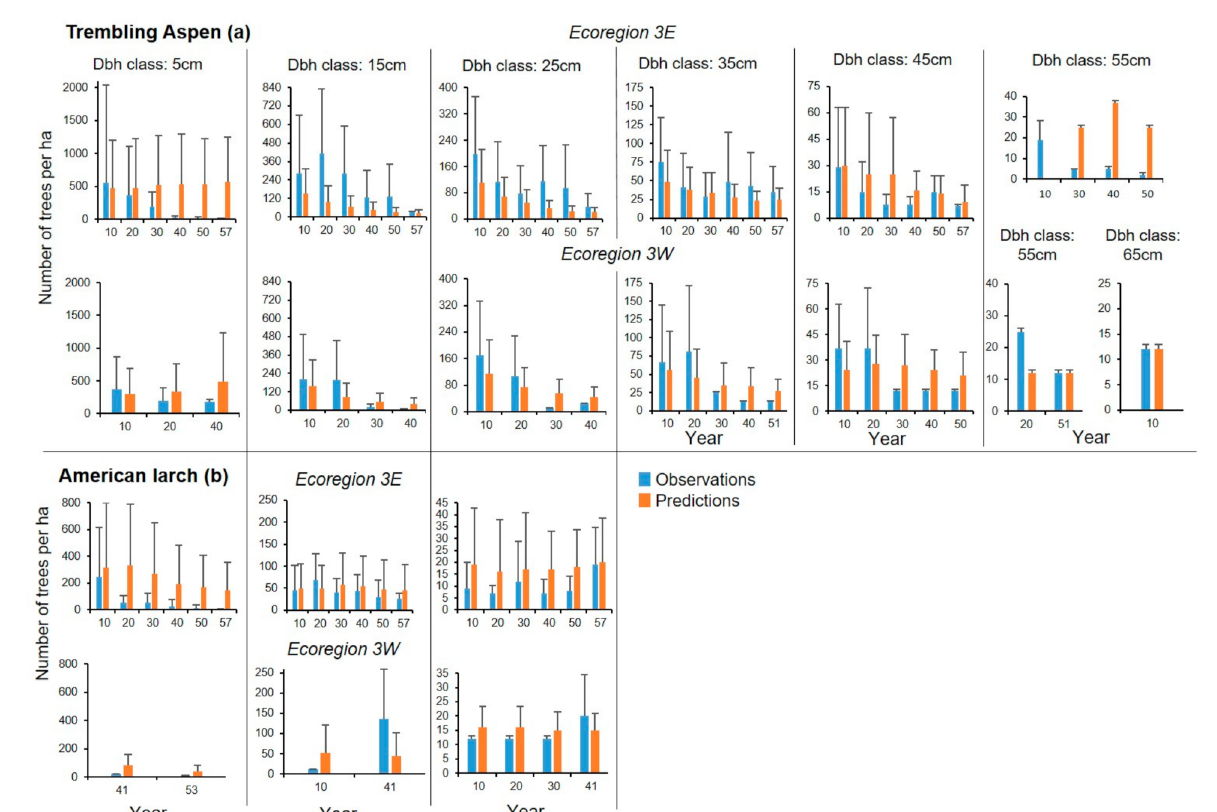
Figure 9. Comparisons between mean observed and predicted stand densities for trembling aspen ( a ) and American larch ( b ) over years in ecoregions 3E and 3W of the boreal forest region of northern Ontario, Canada. Error bars are standard